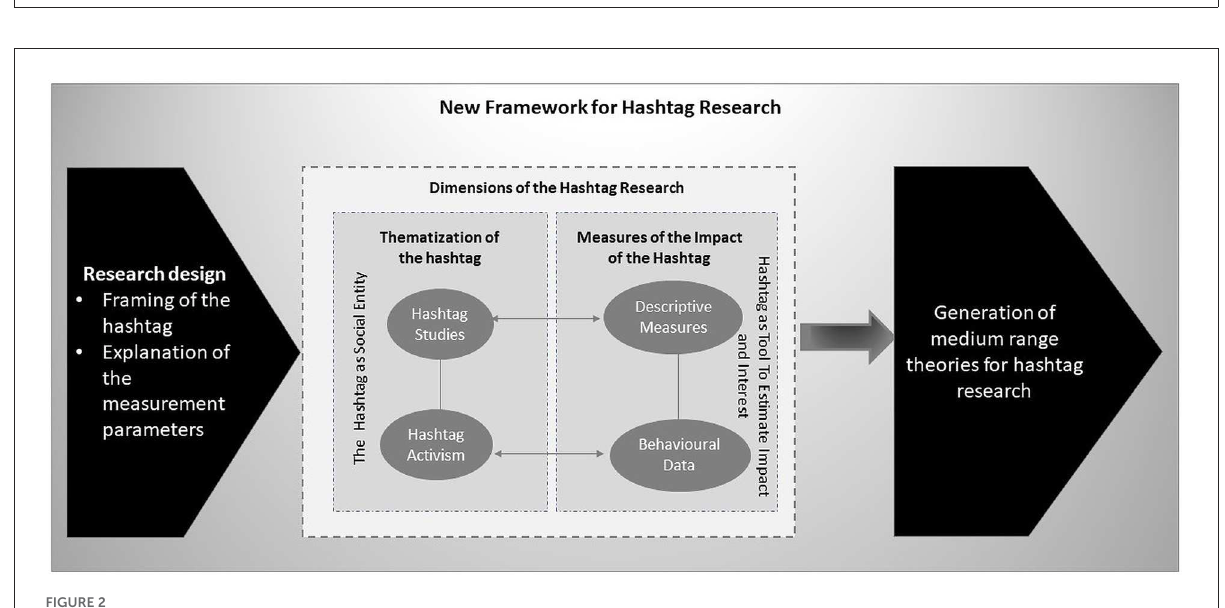
FIGURE2 New perspectives for hashtag